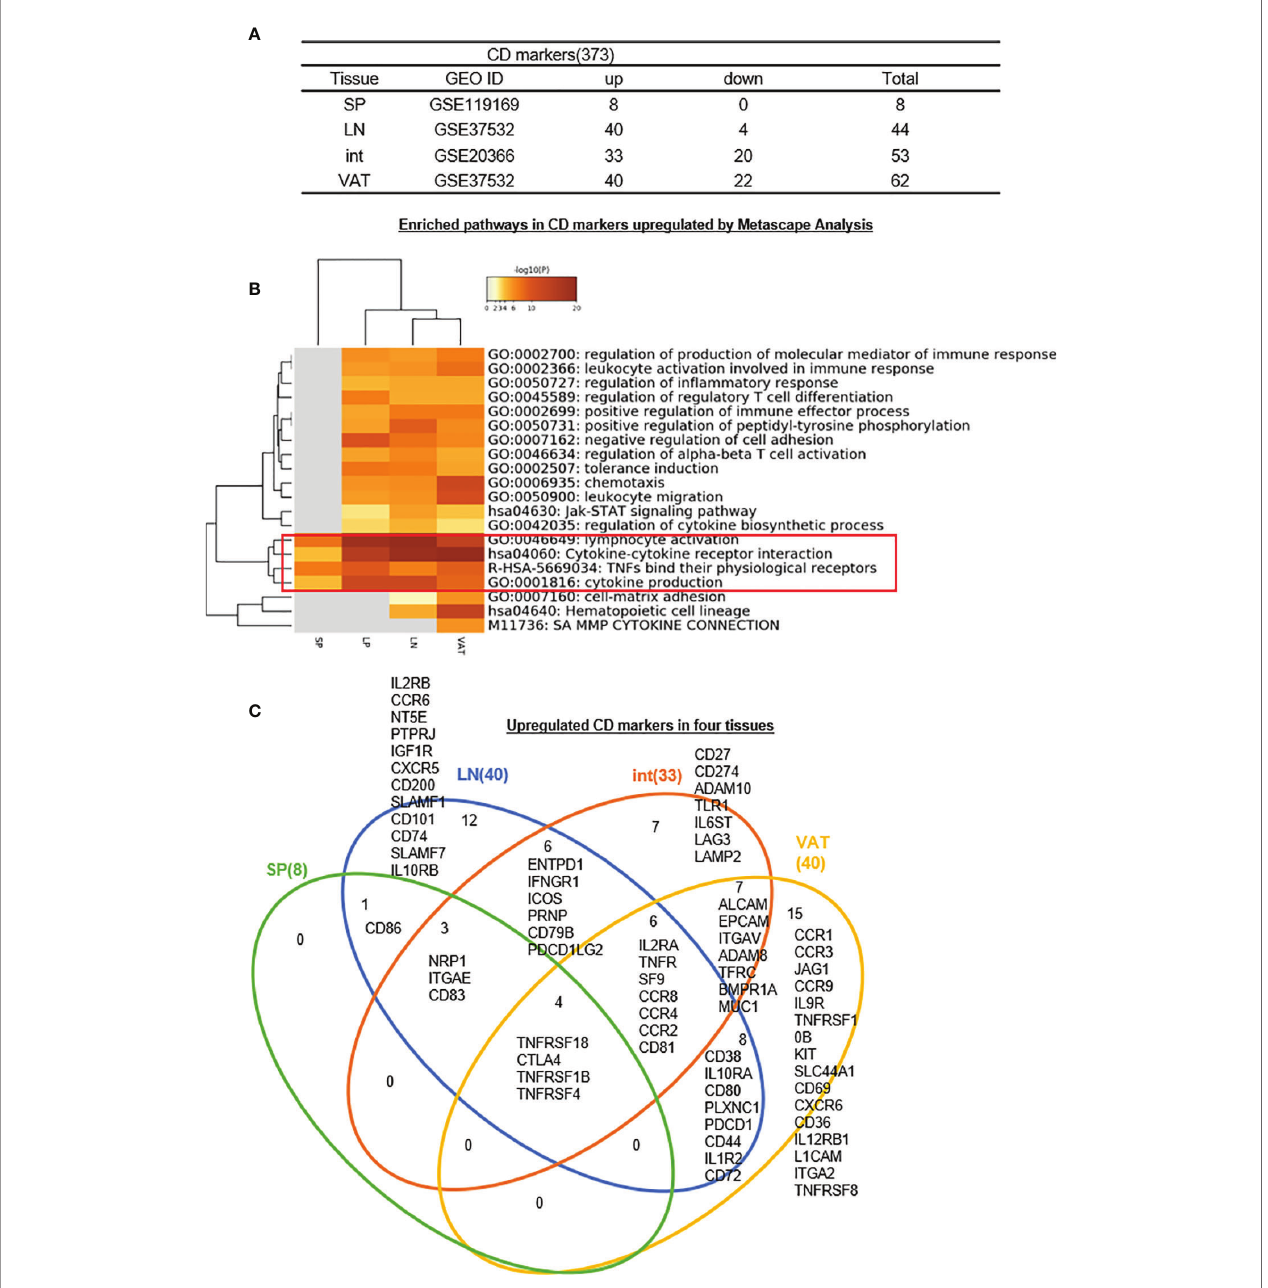
FIGURE 5 | (A – C) Twelve lymph nodes Treg speci fi c CD makers, seven intestine Treg-speci fi c CD makers, and 15 VAT Treg-speci fi c CD makers are identi fi ed, which mediate 20 immune signaling pathways after screening for total 373 CD markers (https://www.proteinatlas.org/search/protein_class:CD+markers) shared (logFC) in four tissues we studied indicating modulation and plasticity of Treg in tissues and Metascape analysis showed that cytokine-cytokine receptor interaction, TNFs binding their physiological receptors and cytokine production were all active by upregulated CD markers, showing important function of cytokines and TNF receptors of Treg; Immunoregulatory interactions between a lymphoid and a non-lymphoid cell was downregulated in Treg. See the detailed data in Supplementary Figure 4